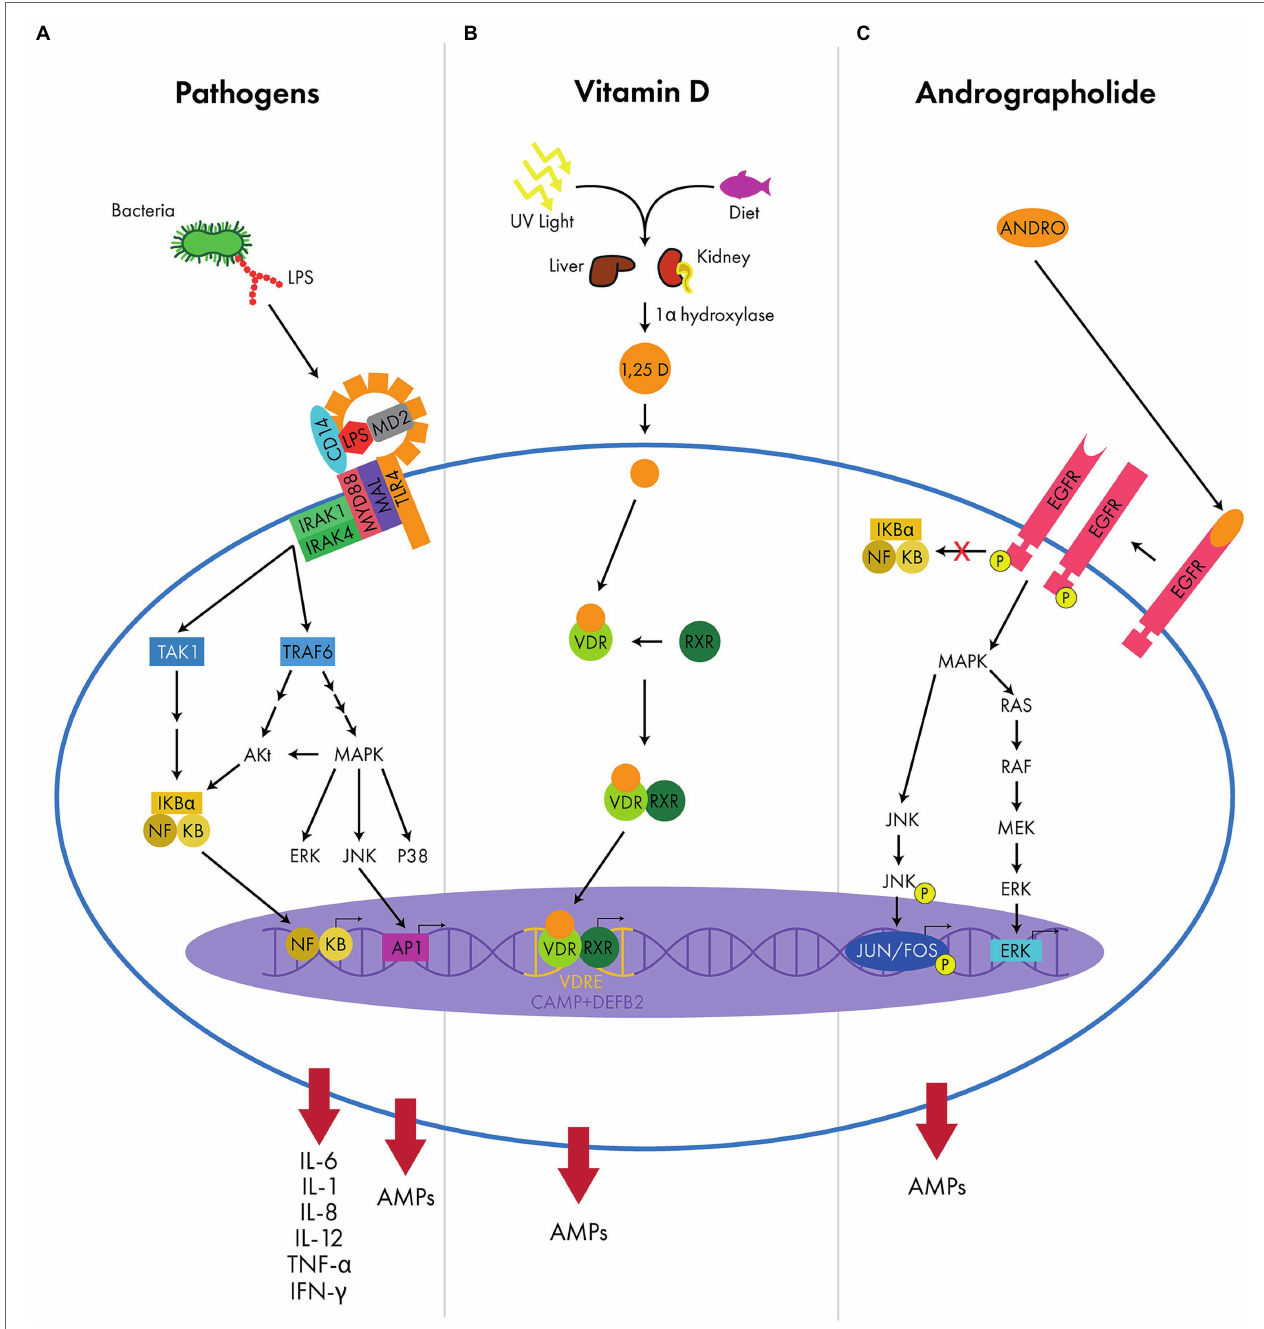
FIGURE 3 | Examples of the signaling molecules and pathways that result in upregulation of AMP expression. (A) The LPS complex (TLR4, CD14, and MD2) recognizes PAMPS (LPS) and uses adapter proteins (MyD88 and MAL) to activate intracellular protein kinases (IRAK1 and IRAK4). These intracellular kinases trigger a signaling cascade (TAK1, TRAF6, Akt, MAPK and the subfamilies ERK/JNK/P38) initiating transcription factors (NF- κ B and AP1) to upregulate AMPs and pro-inflammatory cytokines (IL-6, IL-1, IL-8, IL-12, TNF- α , and IFN- γ ). (B) Vitamin D is absorbed from the conversion of UV light in the skin or from the diet and is metabolized by various enzymes (1 α -hydroxylase) of the kidney and liver to produce the active metabolite, calcitriol (1,25 D). Calcitriol will bind intracellular receptors (VDR and RXR) that heterodimerize and target specific DNA sequences with VDREs, such as CAMP and DEFB2 , to upregulate AMP expression. (C) Andrographolide (ANDRO) activates a ligand-induced dimerization of epidermal growth factor receptor (EGFR), allowing for tyrosine kinase activity and auto-phosphorylation. This triggers an intracellular signaling cascade (MAPK and subfamilies RAS/RAF/MEK/ERK and JNK), activating transcription factors (JUN/FOS and ERK) to upregulate AMP expression without the activation of the pro-inflammatory NF- κ B